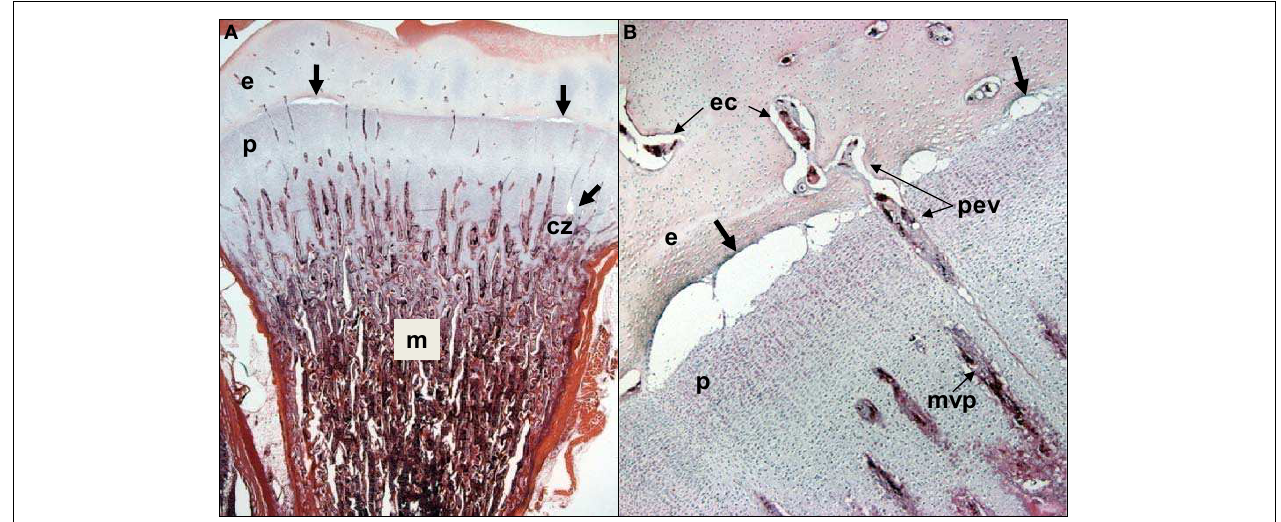
arrows) at the junction of the epiphysis (e) and growth plate or physis (p). A penetrating epiphyseal vessel (pev) is threatened with transection.There is no evidence of inflammation or cellular debris adjacent to or within the clefts.The pre-mortem existence of these clefts cannot be proven, but clearly this key boundary zone is structurally fragile. Osteochondrotic clefts at the epiphyseal-physeal boundary and within the physeal cartilage are considered to predispose broilers to epiphyseolysis, which in turn is considered an early or initial macroscopic manifestation of BCO (Duff, 1984b, 1989a, 1990b;